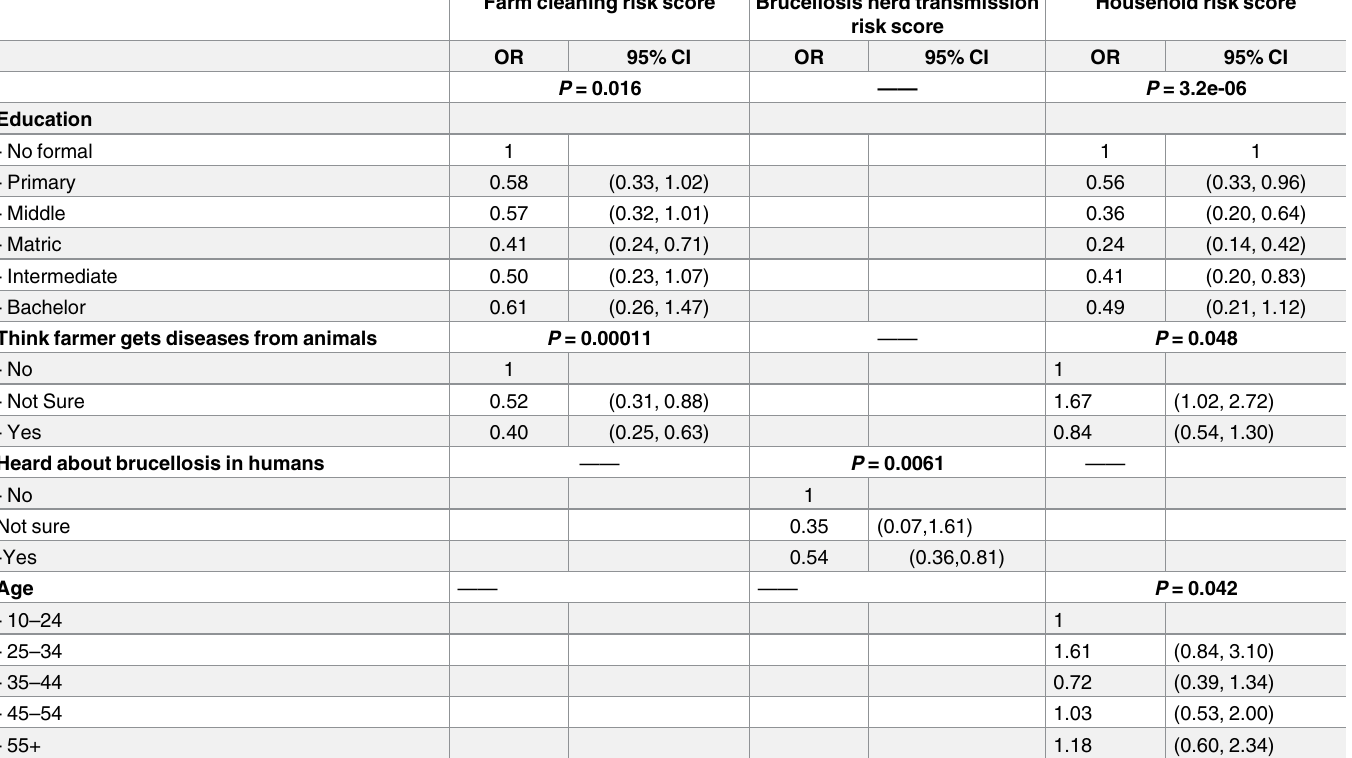
Table 11. Summaryof the final multivariable models for the three risk scores. Columns of the table refer to specific risk scores (outcome variables) and rows refer to predictor variablesafter the backwardelimination process. P -valuesare shown for each predictor variable,followedby the odds ratio (OR) and 95% confidenceinterval(95% CI) for the OR, relativeto the referencegroup(OR = 1). OR from the ordinallogisticmodel refer to the odds of obtaininga certain score of higher, comparedto a lower score, so OR > 1